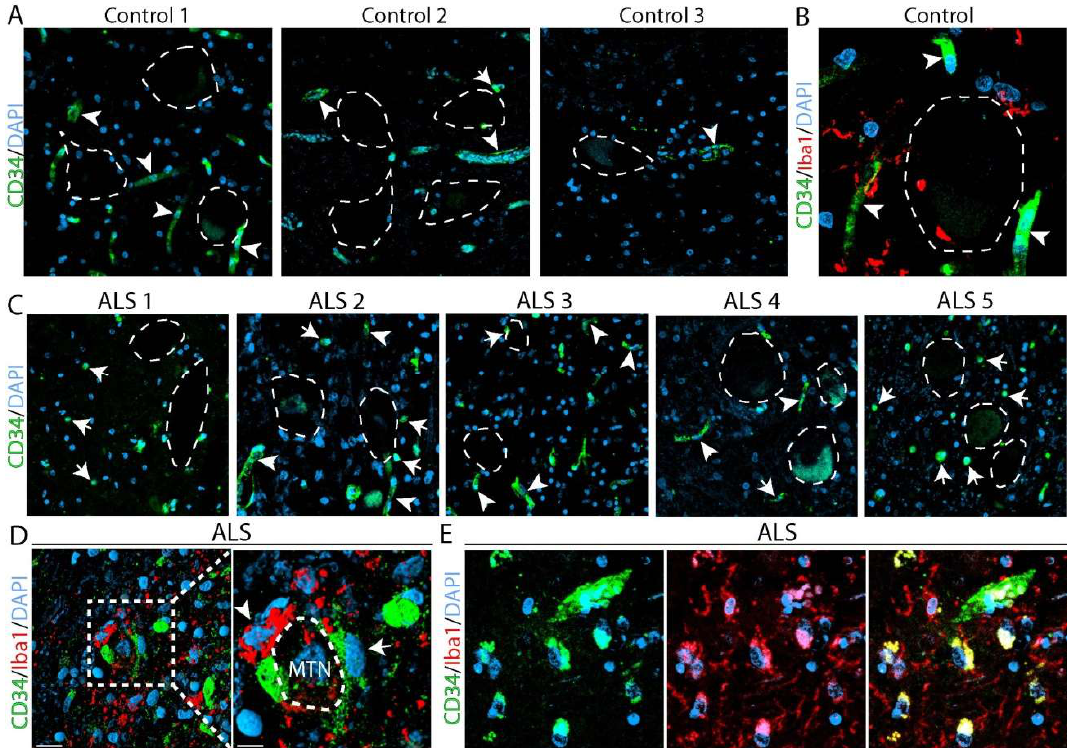
Figure 5. Identification of CD34 + cells in autopsied spinal cords from subjects with sporadic amyotrophic lateral sclerosis (ALS). Representative confocal microphotograph showing the occurrence of non-vascular CD34 + cells in sporadic ALS and control donors. ( A–C ) CD34 + cells (green) in controls and ALS subjects, respectively. Dotted lines delimitate the soma of spinal motor neurons. Note that in control subjects CD34 + cells were associated to blood vessels (arrowheads) with none or few rounded CD34 + cells located adjacent to motor neurons. In comparison, in ALS donors numerous CD34 + cells with round morphology were located in the proximity to apparent motor neuron cell bodies (arrows). ( D ) Confocal image showing the coexistence of Iba1 + cells (red) that surround an apparent motor neuron cell body (dotted lines in right panel) with CD34 + cells in ALS specimens. Note non-vascular CD34 + cells adjacent to motor neurons in ALS specimens but not in controls. ( E ) Co-expression of CD34 with Iba1 in myeloid cells at the ventral horn of the spinal cord of ALS patients. Scale bars: 25 µ m ( A ), 10 µ m ( B ), 50 µ m ( C ), 10 µ m ( D ), 20 µ m ( E ).